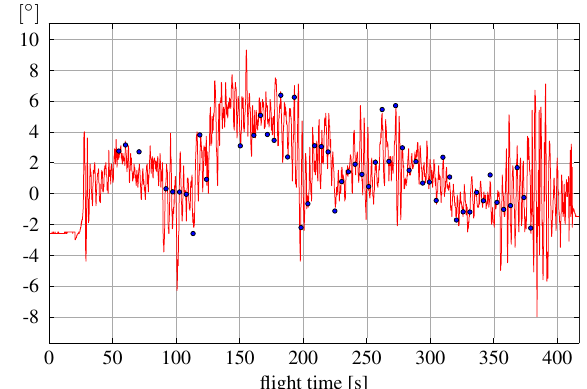
Figure 10: Comparison of direct and indirect georeferencing for the roll angle. The red line represents the direct georeferencing result, whereas the blue dots correspond to the indirect georefer-